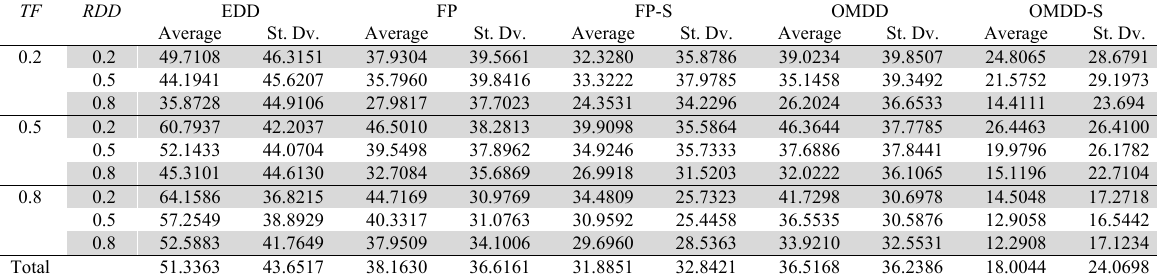
Table 12 and Table 13 present the 𝑅𝐷𝐼 values (average and standard deviation) considering TF and RDD . Once again, SPAM and OMDD-S have returned the best values for the RDI indicator. Also, the FP heuristic has presented the worst performance among the methods under comparison. Large-sized test instances: RDI values for TF and RDD (part 1)